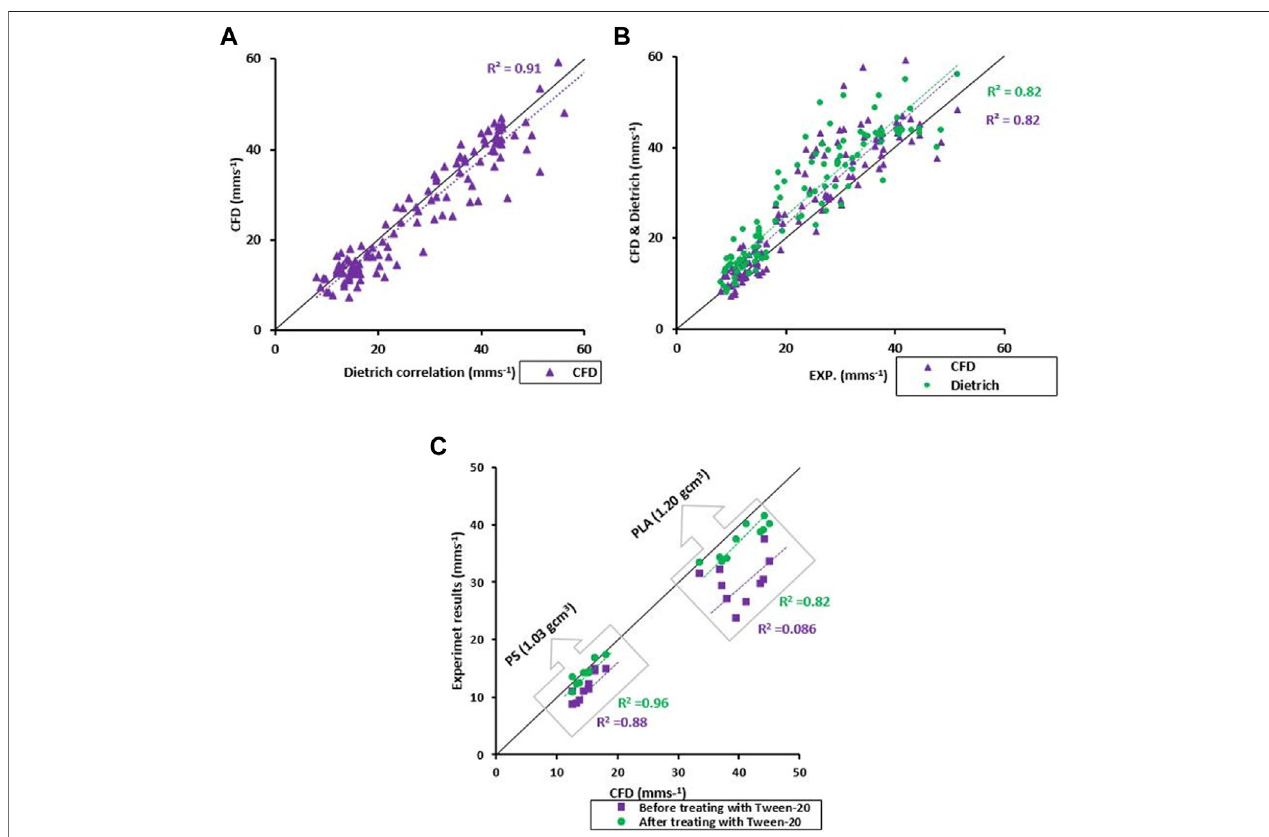
FIGURE 5 | (A) CFD-simulated TSVs for 120 irregular MP particles plotted against TSVs estimated based on the Dietrich relationship. (B) CFD-based TSVs and TSVs estimated with the Dietrich relationship plotted against experimental results. (C) TSV changes due to particles ’ surface treatment using Tween-20 for two sets of MP particles (PS andPLA both intherange from 1to2 mm),thepurple squaresillustratethe TSVs beforetreatmentwithTween-20and the greencircles represent their TSVs from the re-run experiments after the treatmeant with Tween-20.